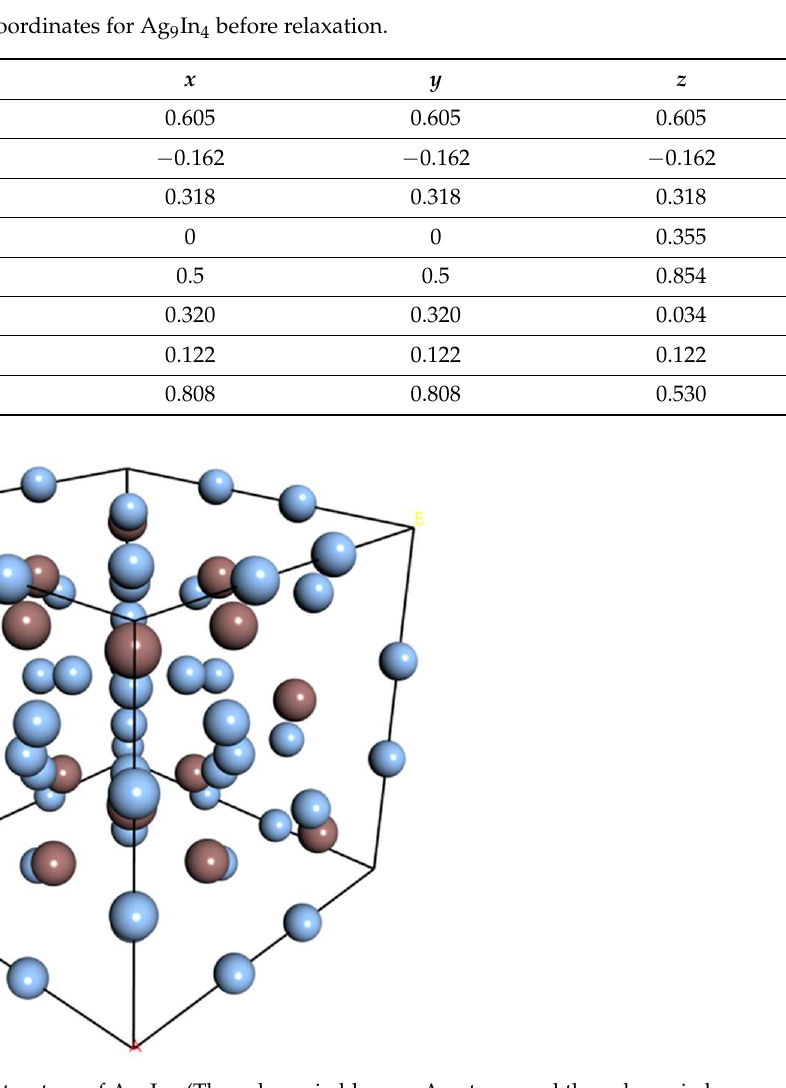
Figure 1. Crystal structure of Ag 9 In 4 (The spheres in blue are Ag atoms and the spheres in brown are In atoms).